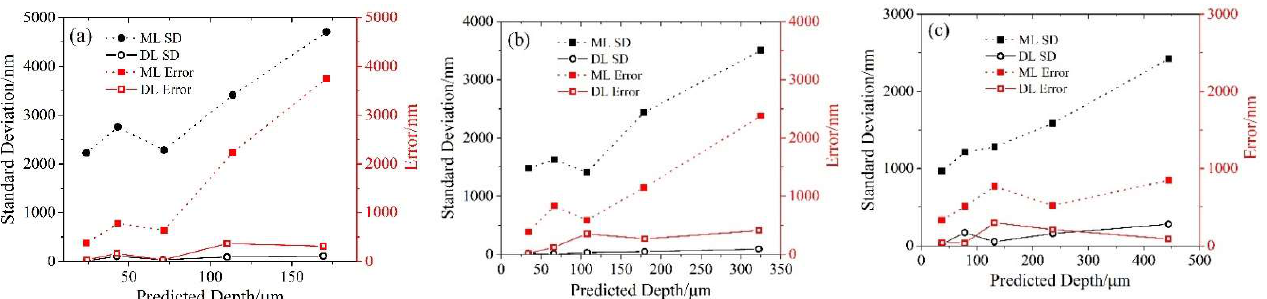
8 of 10 Figure 8. Standard deviation and error of width results for widths around ( a ) 2 μm, ( b ) 10 μm, and ( c ) 30 μm, predicted by machine learning model (dot line) and deep learning model (solid line). ML, machine learning; DL, deep learning; SD, standard deviation. Figure 9 illustrates the standard deviation and error of the depth prediction results.